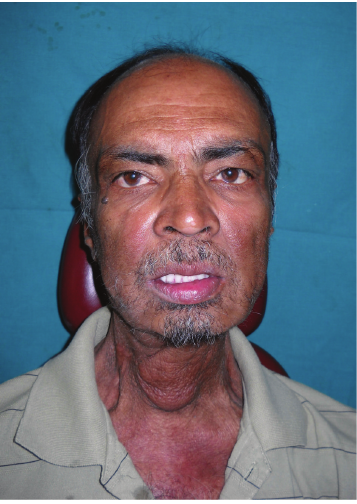
Figure 13: Postoperative extraoral